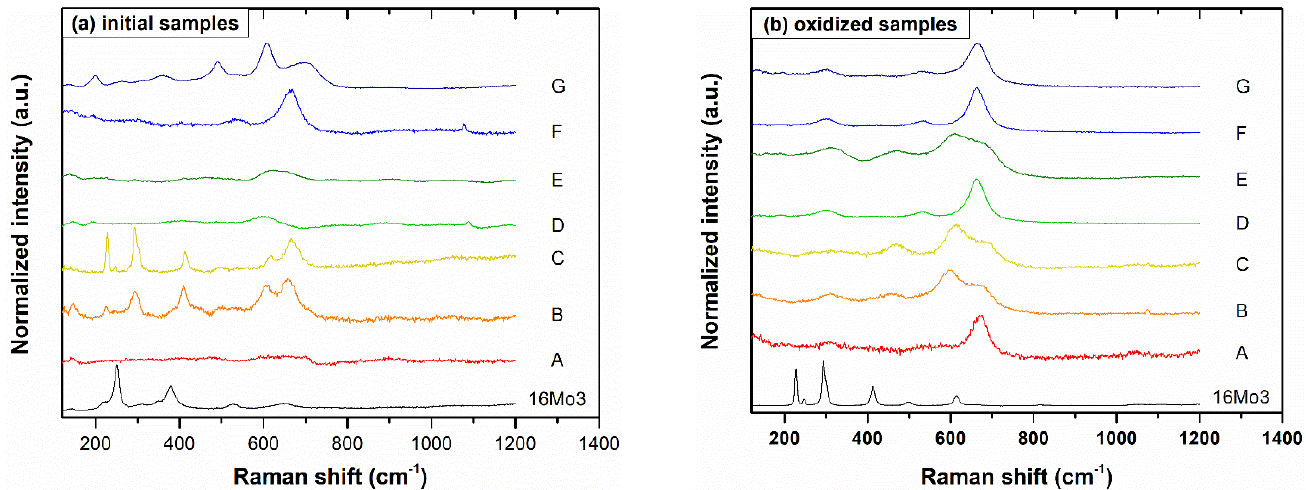
Figure 4. Raman spectra for ( a ) initial and ( b ) oxidized samples at 650 °C for 48 h in Ar-10%H2O atmosphere.